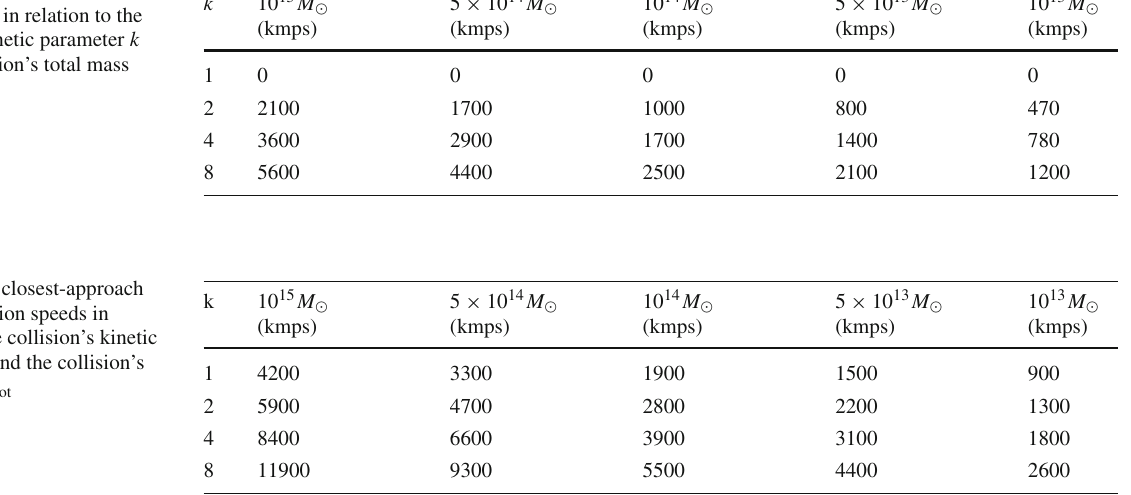
in-fall speeds in relation to the collision’s kinetic parameter k and the collision’s total mass M